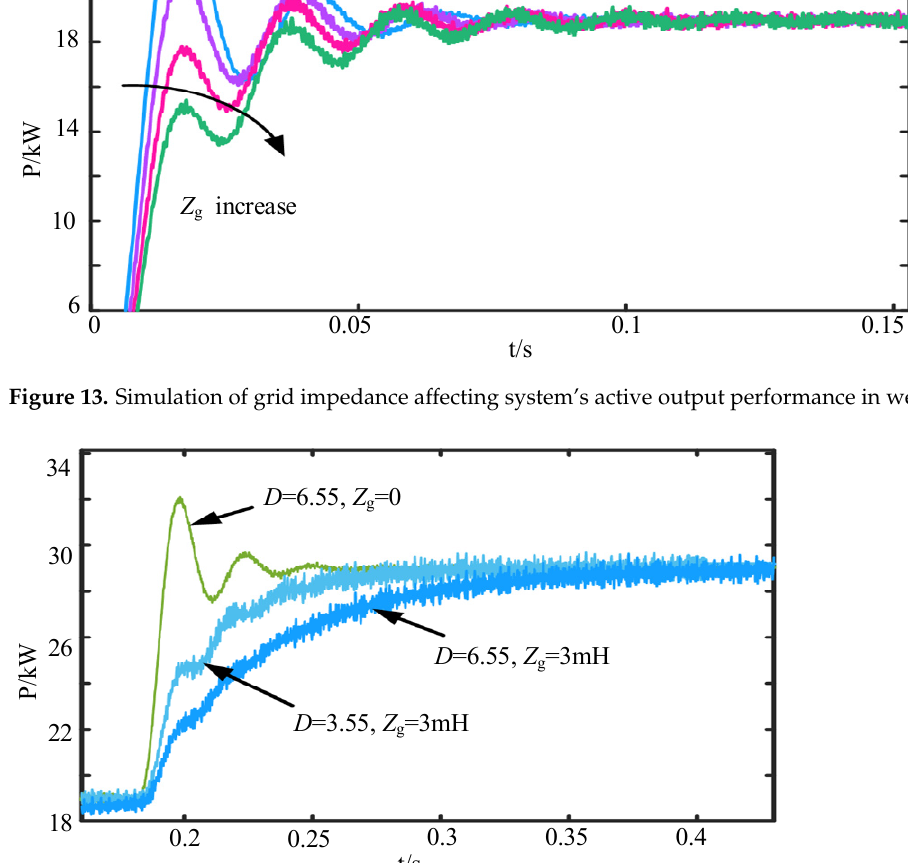
Table 1. Simulation platform parameters.